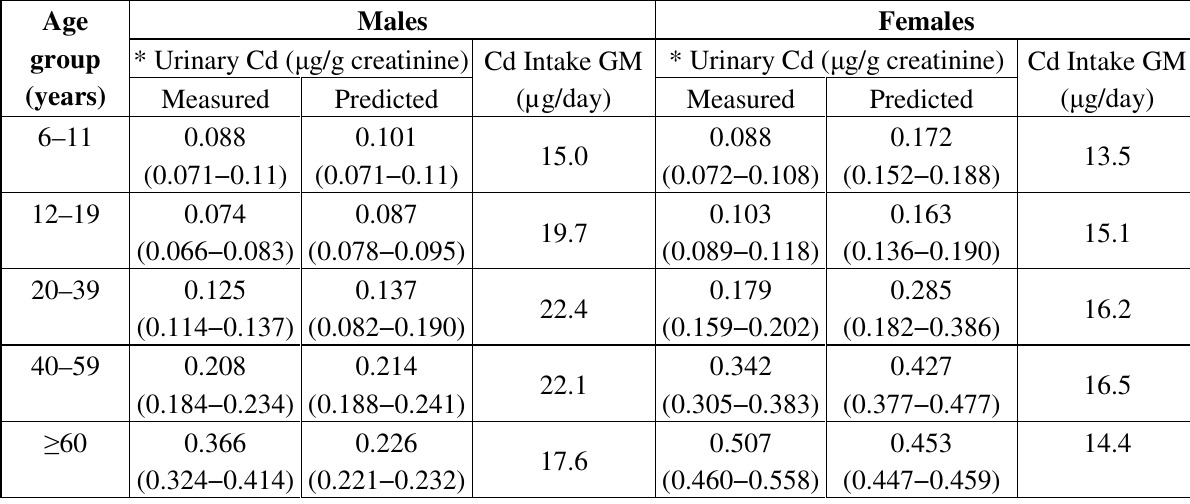
Table 3. Dietary cadmium intake, model predictions, and geometric mean urinary cadmium concentrations in nonsmoking male U.S. population (National Health and Nutrition Examination Survey: NHANES